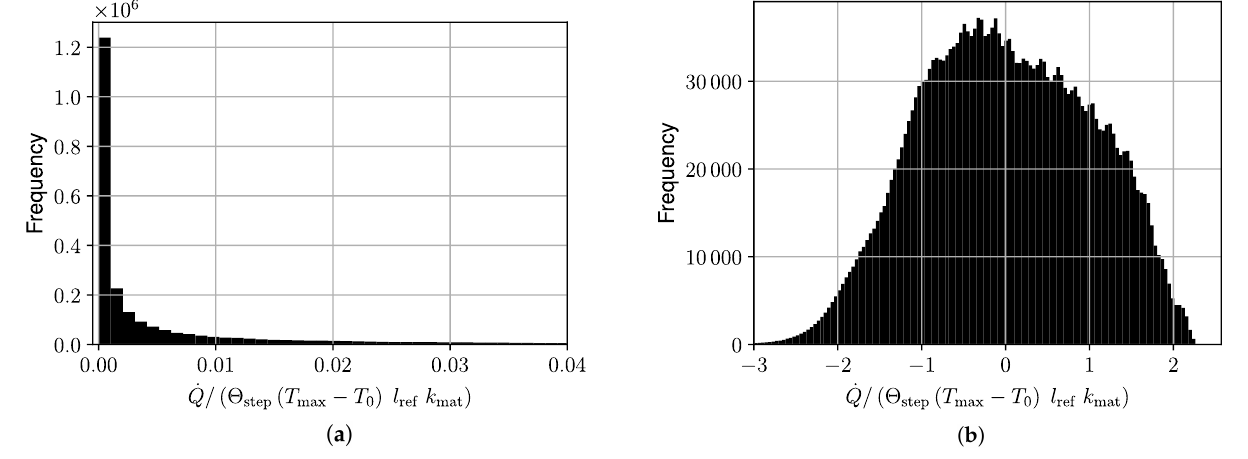
Figure 6. Histogram of targets in training set ( a ) before scaling and ( b ) after